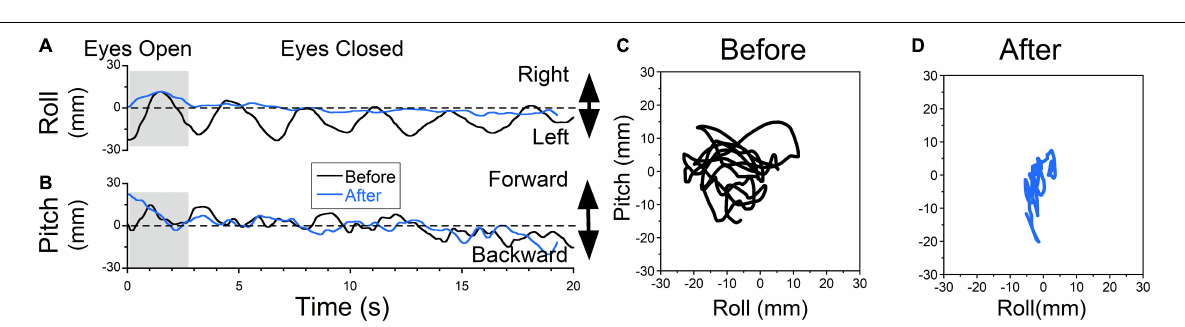
FIGURE 7 | Static posturography of a 48-year-old female with MdDS triggered immediately after a cruise. Details of individual plots are described in Figure 6 . The patient experienced a sensation of gravitational pulling to the left ( A , black trace) and some rocking ( B , black trace). When the eyes were closed, the patient’s body gradually drifted to the left. When the posture reached a certain deviation from upright, to gain stability patient quickly moved her body back to the upright position. This is different from body swaying when oscillation is sinusoidal and body deviations are symmetrical about upright. After exposure to OKS to the right at 5 ◦ /s for 2 min, the sensation of gravitational pulling to the left was reduced ( C , blue traces). As a result, side-to-side body oscillations were no longer observed. Minimal forward-back body oscillations remained unchanged ( D , blue traces). (D) Trajectory plots of COP before (C) and after (D) treatment. After treatment, postural stability increased ( A,B,D blue